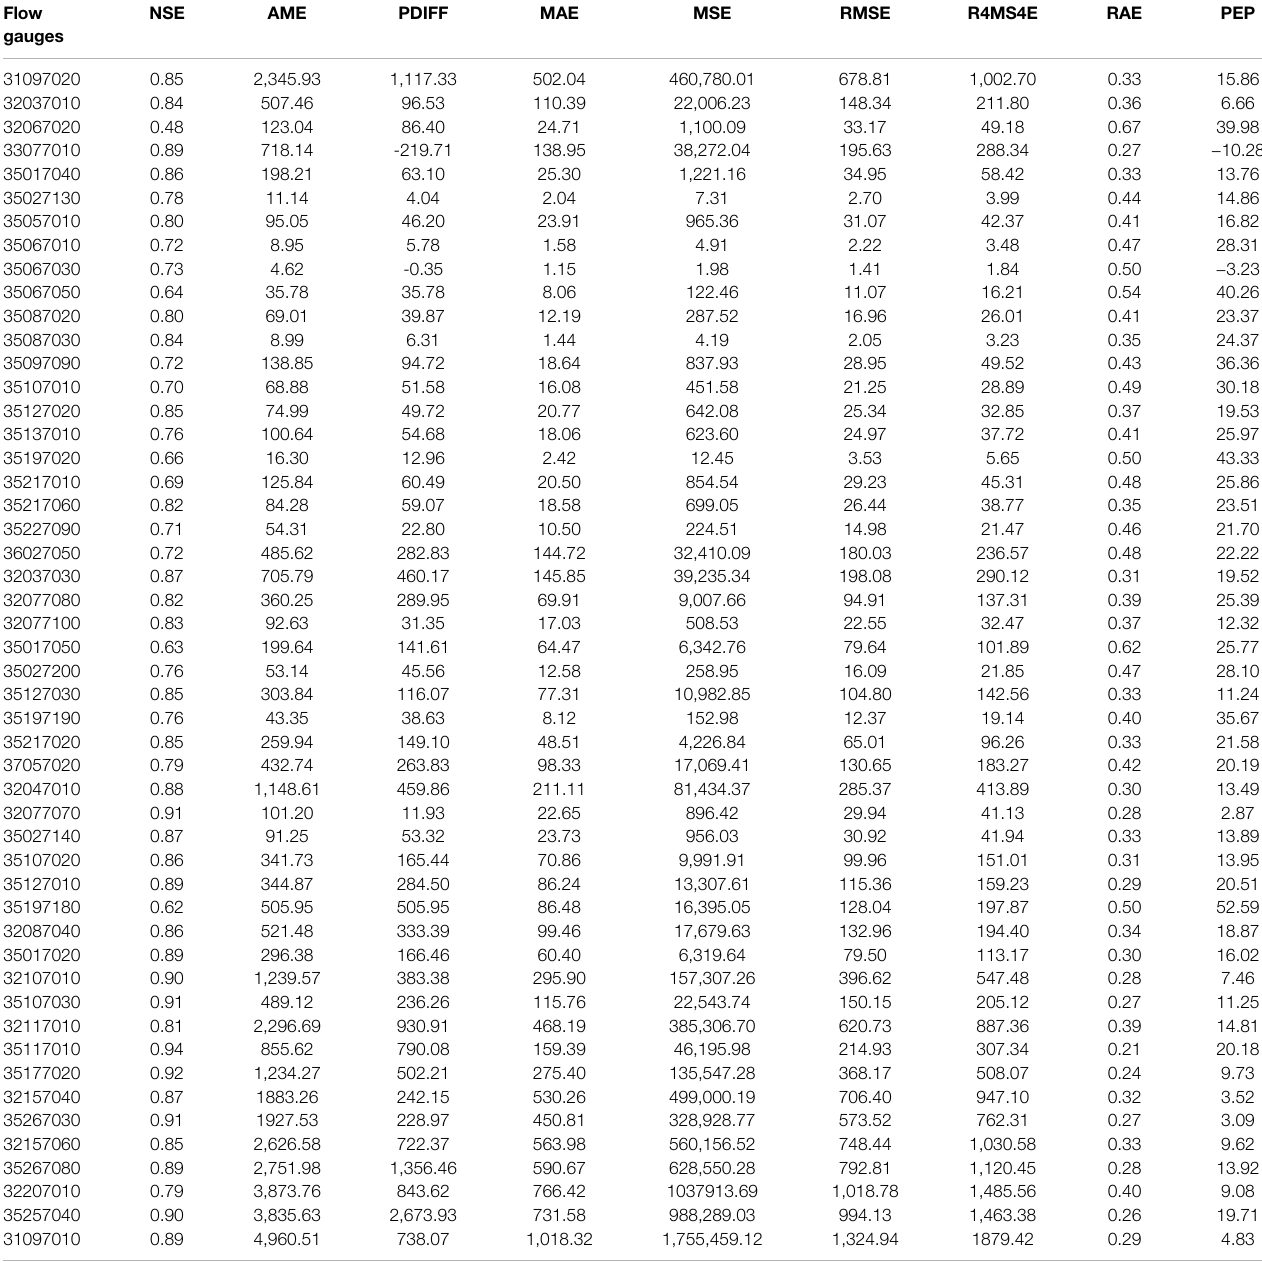
TABLE 2 | Model performance metrics in